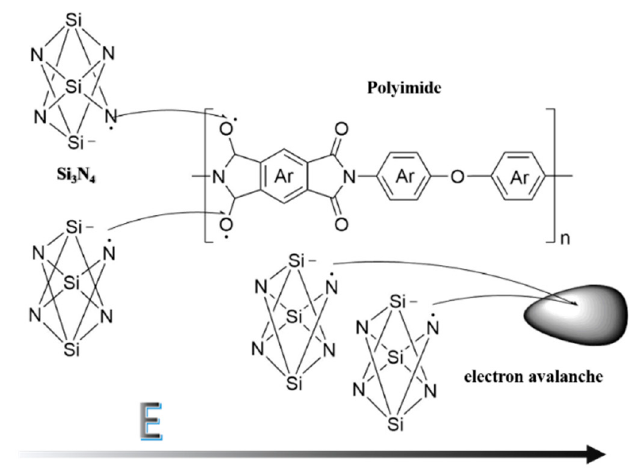
Figure 5. The model of electron avalanche for PI/Si 3 N 4 .